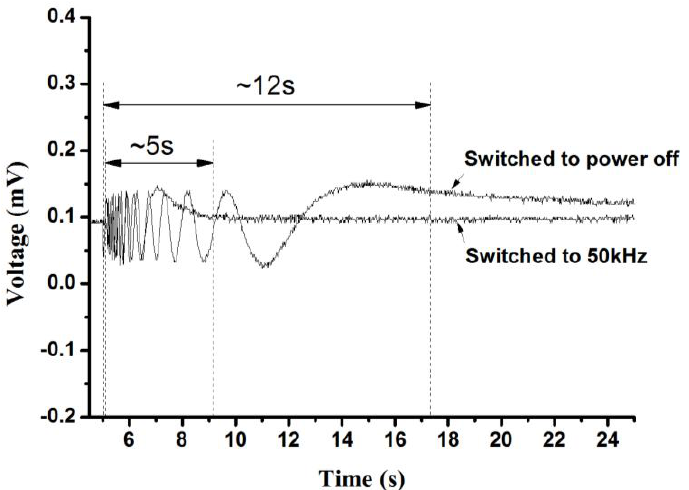
Figure 11. Output signal of the power meter in mV illustrating recovery times for the two cases with power-off and driving frequency in 50